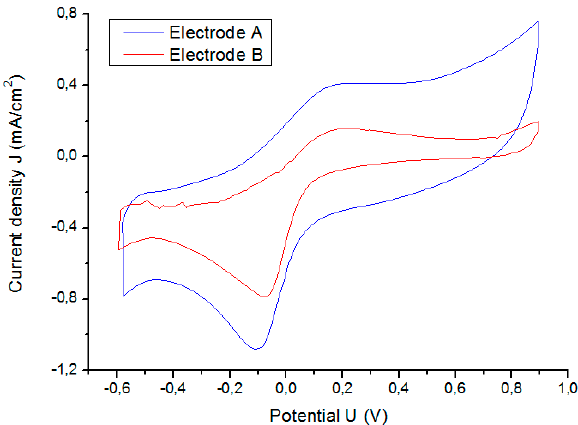
Figure 10. Comparison of results of cyclic voltammetry for Pt microelectrodes A and B (see Table 1). Scan rate was 100